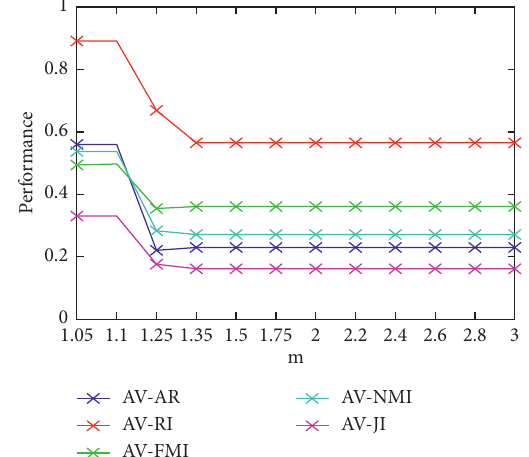
Figure 9: Performance comparison of differnet time conditions using C-FCM data